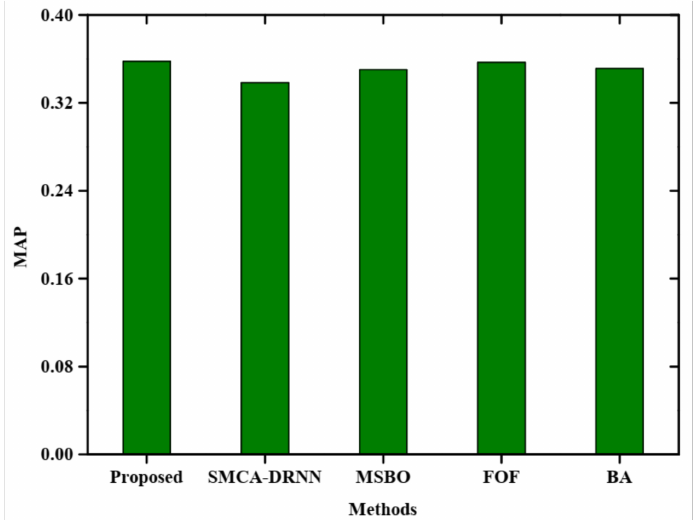
Figure 4. Comparative analysis of MAP with query